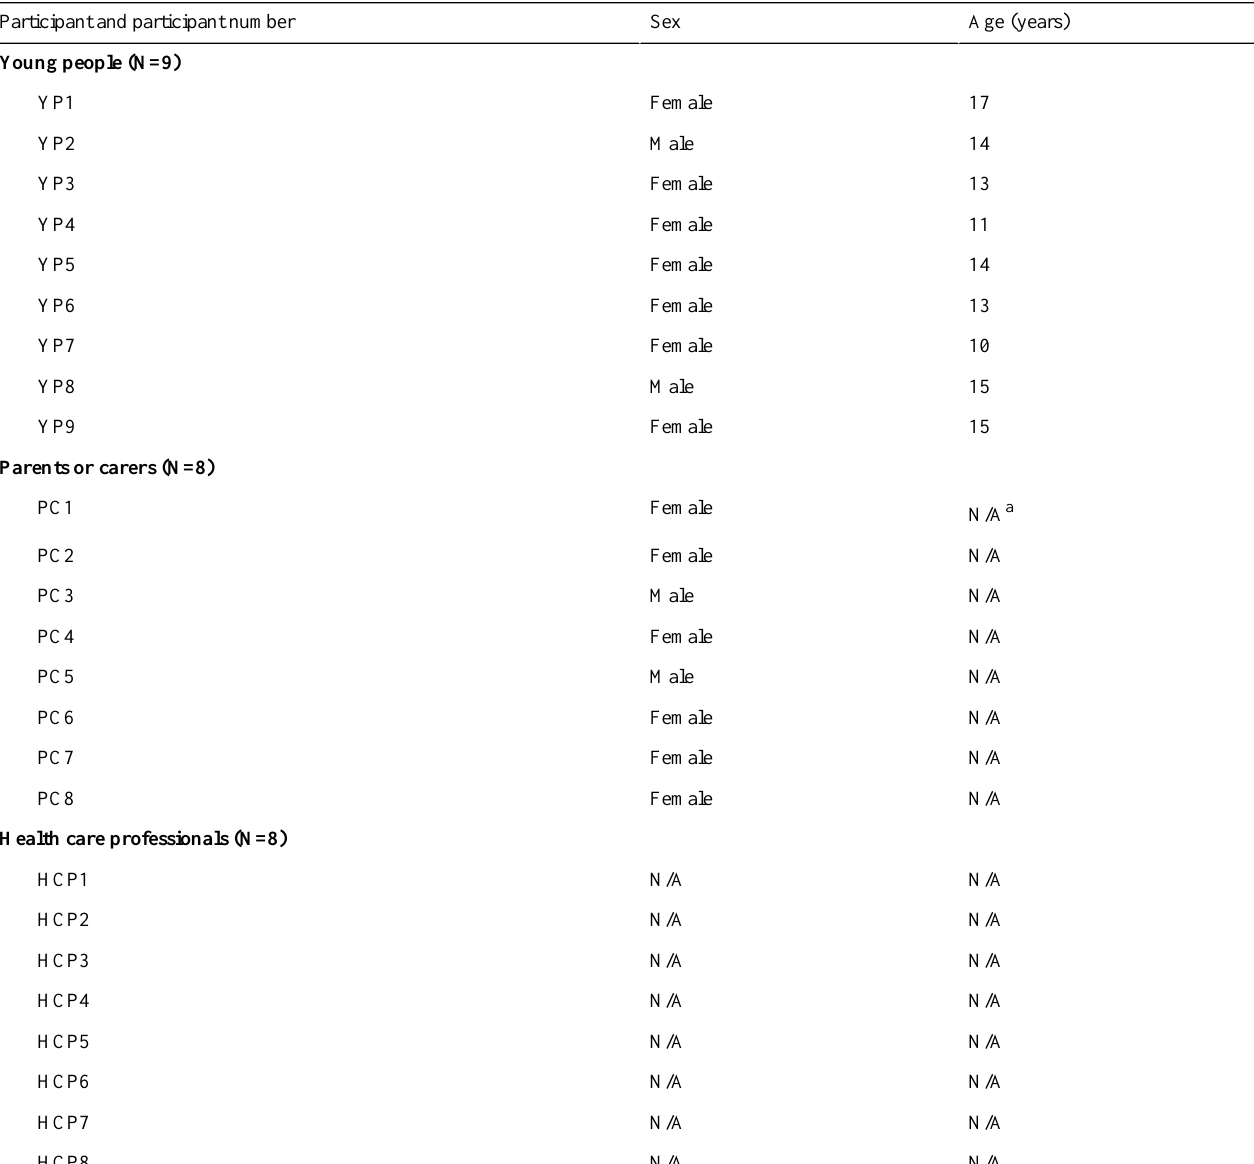
Table 1. Participants' demographics. HCP: health care professional; PC: parents or carers; YP: young